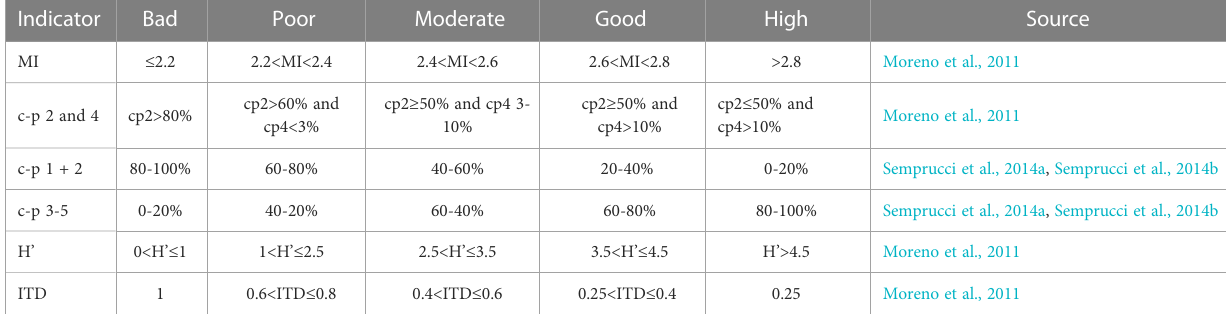
TABLE 1 Thresholds of nematode community descriptors as environmental quality indicators.